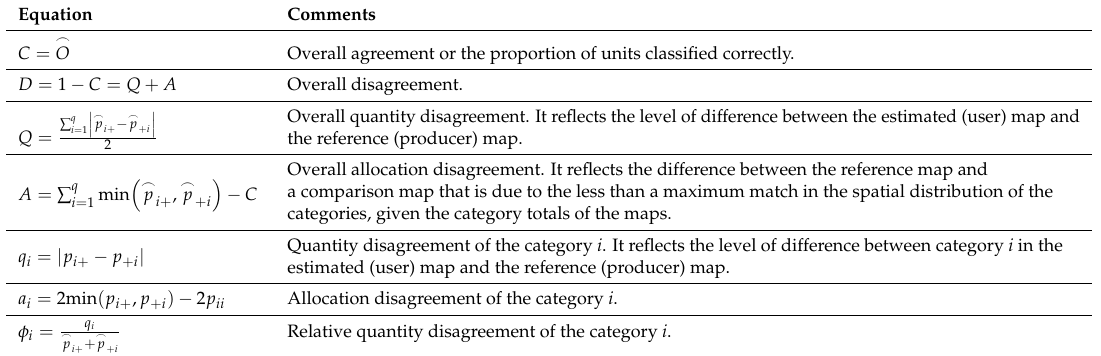
Table 4. Quantity and allocation disagreement assessment